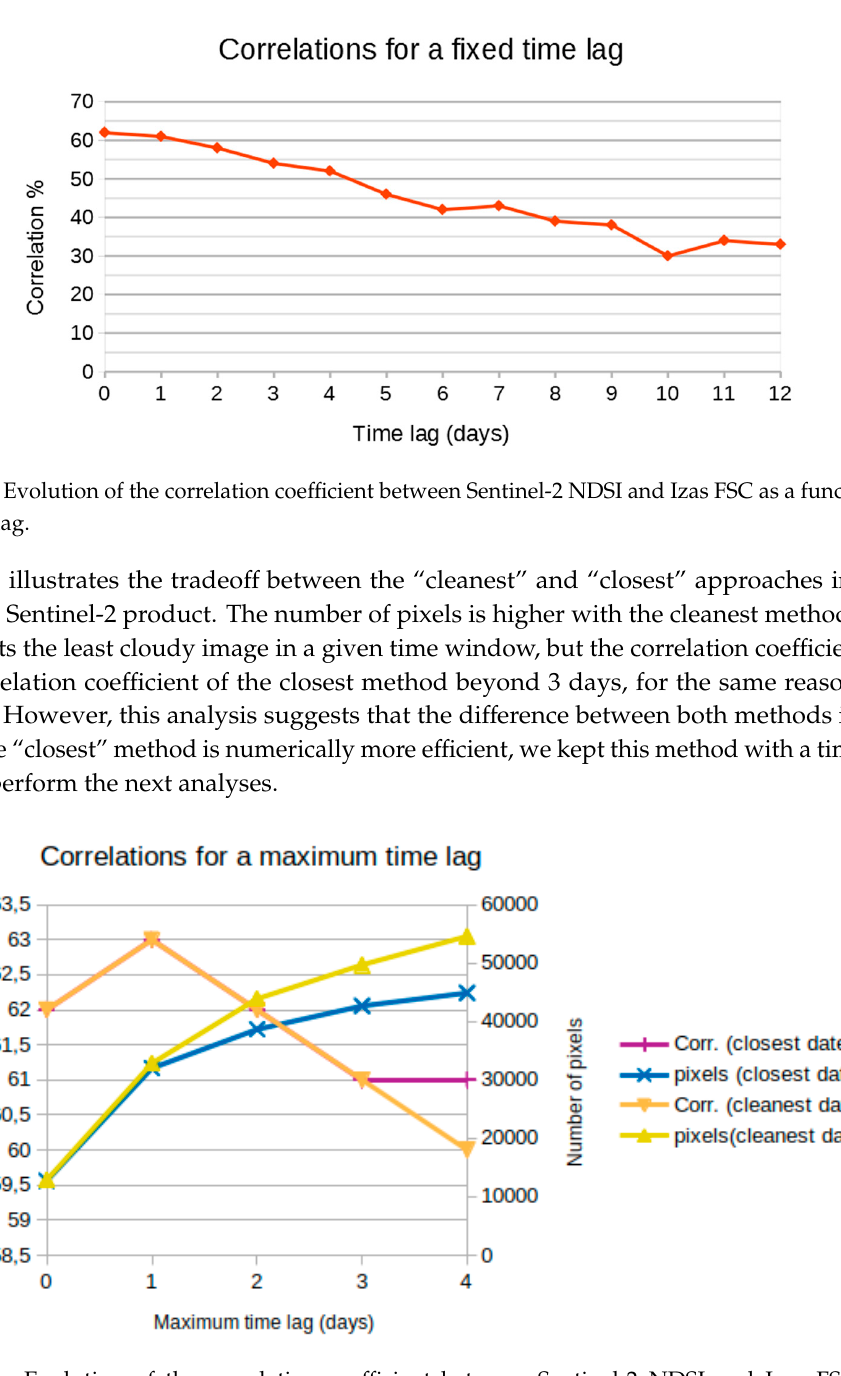
Figure 10. Results of the evaluation of the FSC using ODK data. Blue line: Linear regression between the predicted and the testing FSC sets. Green line: 1:1 line. The color bar indicates the number of samples by bin. 3.3. Evaluation with Remote Sensing Data The results are presented for each set of remote sensing data used: ● SPOT: The results for SPOT are separated by date (Tables 4 and 5). The RMSE ranges between 21% and 31%, close to those obtained with the calibration–validation dataset (RMSE = 25%; Section 3.1 ). The absolute value of the mean error ranges between 13% and 0.04%, indicating that, despite a rather large dispersion, the FSC is not strongly biased. ●